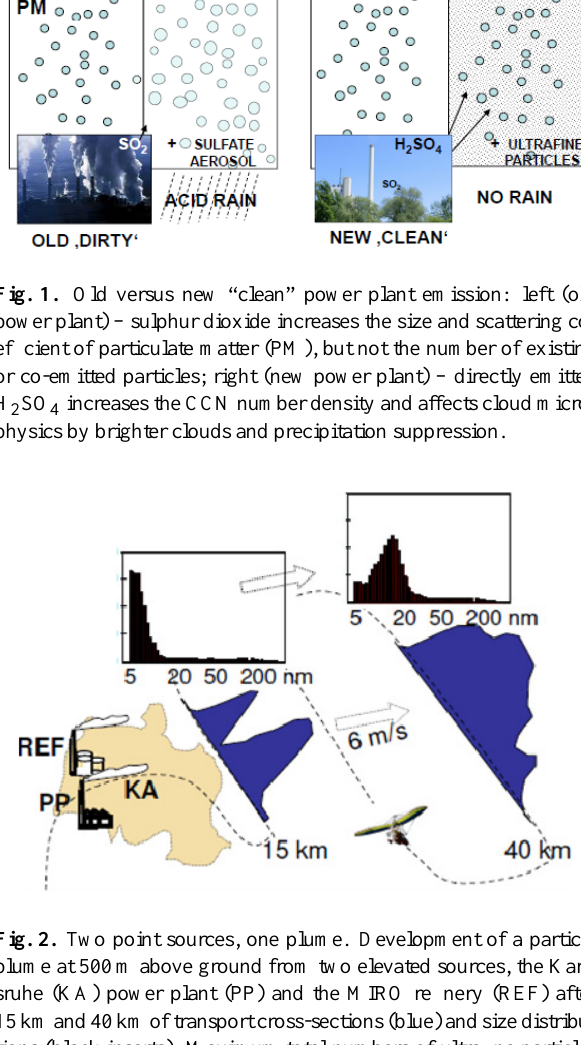
Fig. 2. Two point sources, one plume. Development of a particle plume at 500m above ground from two elevated sources, the Karl- Fig. 2: Two point sources, one plume. Development of a particle plume at 500 m above sruhe (KA) power plant (PP) and the MIRO refinery (REF) after ground from two elevated sources, the Karlsruhe (KA) power plant (PP) and the MIRO 15km and 40km of transport cross-sections (blue) and size distribu- tions (black inserts). Maximum total numbers of ultrafine particles refinery (REF) after 15 km and 40 km of transport cross-sections (blue) and size ( D > 10nm) reach ∼ 50000cm − 3 . These particles are expected to distributions (black inserts). Maximum total numbers of ultrafine particles (D > 10 nm) grow into CCN sizes after transport for another ∼ 100 to 150km reach ~ 50000 cm -3 . These particles are expected to grow into CCN sizes after transport for another ~100 to 150 km For wind and turbulence, the DIMONA installation in- cludes a BAT (Best Aircraft Turbulence) probe (Crawford et al. 1992), while the ultra-light aircraft carries a